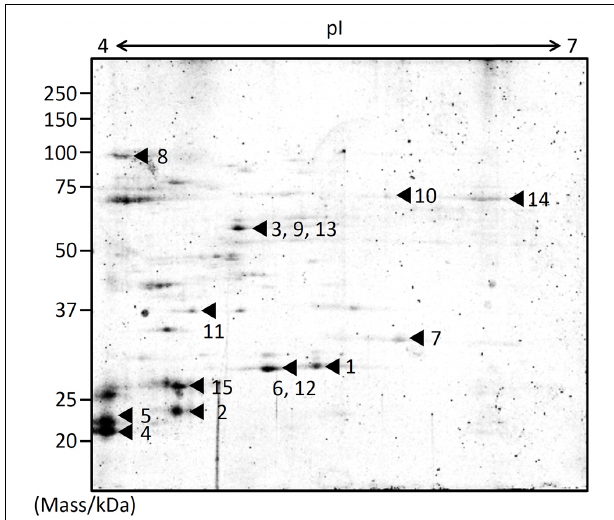
FIGURE 2 | Protein profiling of EMVs. Proteins extracted from the EMVs produced by (cid:49) gspD2 were subjected to 2D-PAGE and peptide mass fingerprinting. The black arrowheads and the following numbers indicate the identified proteins listed in Table 3 . The spot numbered 7 indicates HM1275.